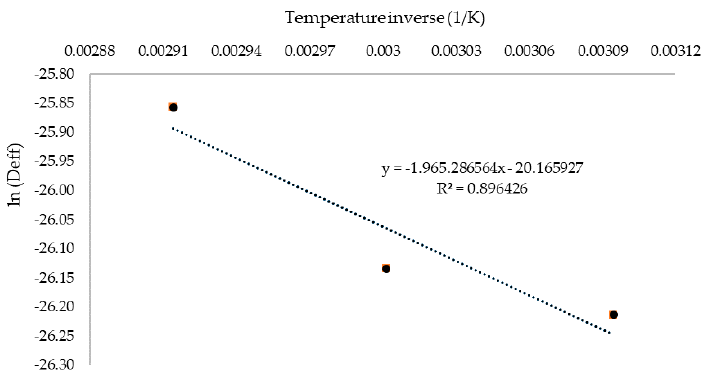
Figure 7. lnD eff versus absolute temperature inverses (T). Figure 7. ln D e ff versus absolute temperature inverses